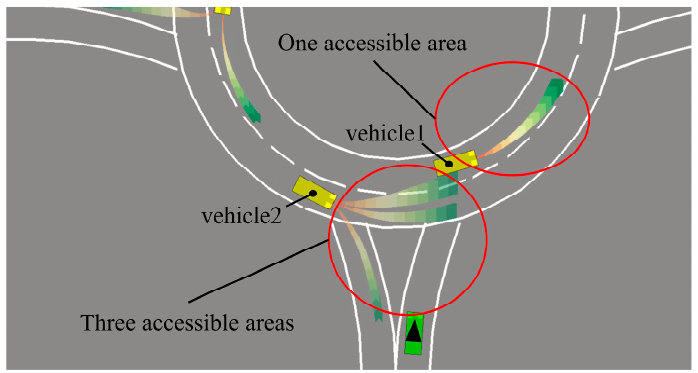
Figure 4. Interval prediction in